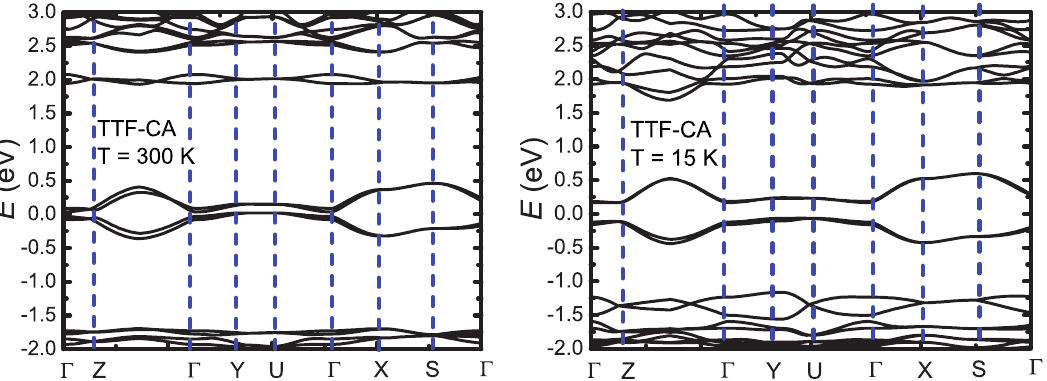
Figure 10. Band structure of TTF-CA at room temperature ( T = 300 K) and low temperatures ( T = 15 K) along the selected k -path in an energy range from − 2 eV to 3 eV: Γ ( 0,0,0 ) → Z ( 0,0,0.5 ) → Γ ( 0,0,0 ) → Y ( 0,0.5,0 ) → U ( 0,0.5,0.5 ) → Γ ( 0,0,0 ) → X ( 0.5,0,0 ) → S ( 0.5,0.5,0 ) → Γ ( 0,0,0 ) . The band gaps are 0.02 eV at T = 300 K and 0.23 eV at 15 K.